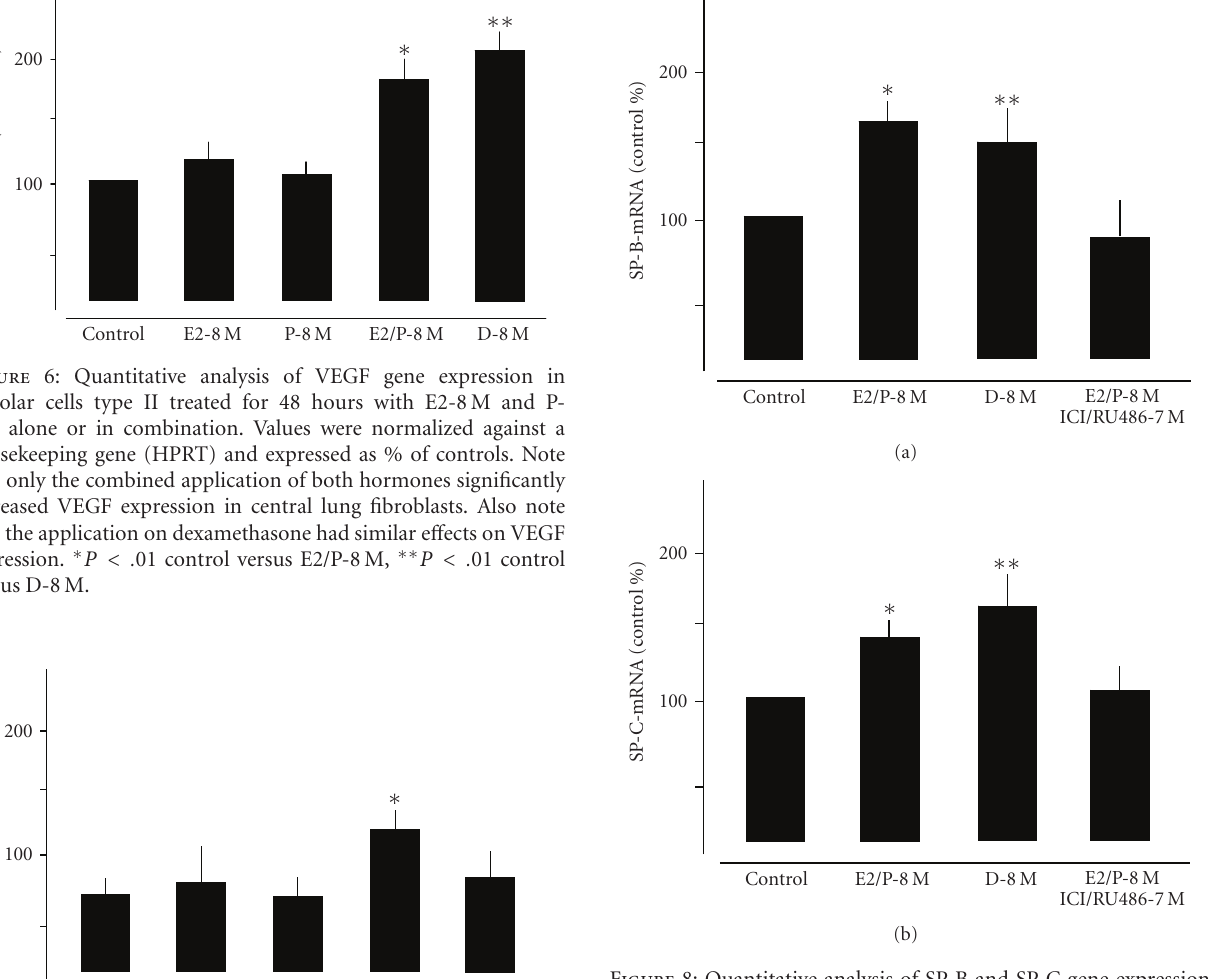
Figure 8: Quantitative analysis of SP-B and SP-C gene expression in alveolar cells type II treated for 48 hours with E2-8M/P- 8M in combination or with dexamethasone-8 M. Values were normalized against a housekeeping gene (HPRT) and expressed as % of controls. Note that combined hormonal treatment increased expression of both surfactant proteins to a similar extent like dexamethasone. Further note that pretreatment with the receptor antagonists ICI and RU 486 antagonized the hormonal e ff ects. ∗ P < . 01 control versus E2/P-8M; ∗∗ P < . 01 control versus